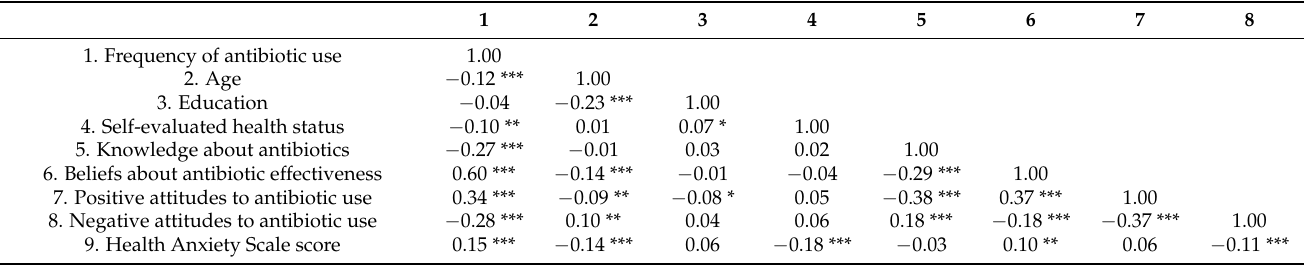
Table 3. Correlations among study